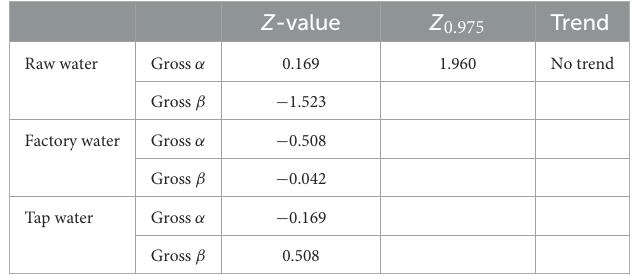
TABLE 4 Statistical test for the temporal trend of drinking water radioactivity in 2014–2021 around